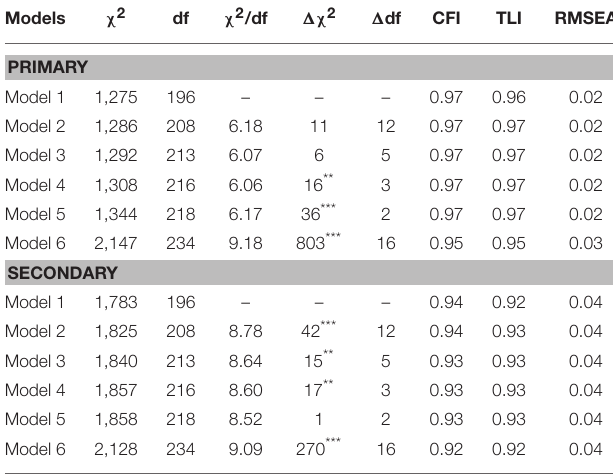
educational stage.